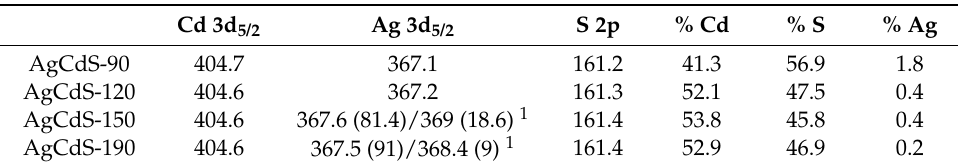
Table 3. XPS binding energies (eV) of core levels and surface composition (atomic percentages) of AgCdS-T photocatalysts Cd 3d 5/2